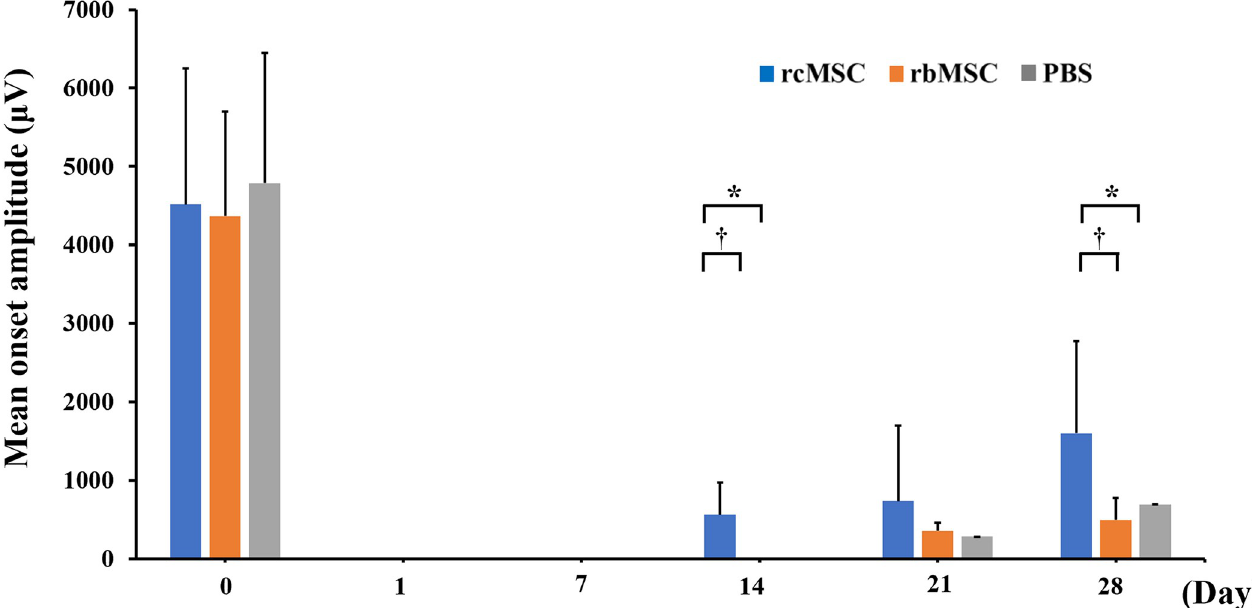
Fig 4. Mean onset amplitude of each group. The mean amplitude values showed an increase over time for each group. Data are presented as mean ± standard deviation; n = 10 for each group. � P < 0.05, phosphate buffered saline (PBS) group vs. rat cranial bone-derived mesenchymal stem cell (rcMSC) group; †P < 0.05, rcMSC group vs rat bone marrow-derived mesenchymal stem cell (rbMSC) group.